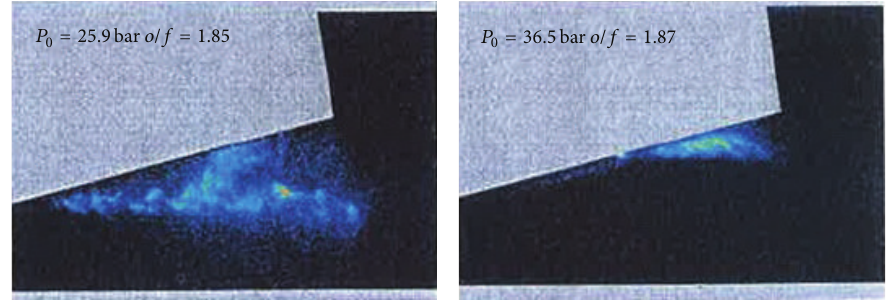
P 0 = 25.9 bar o / f = 1.85